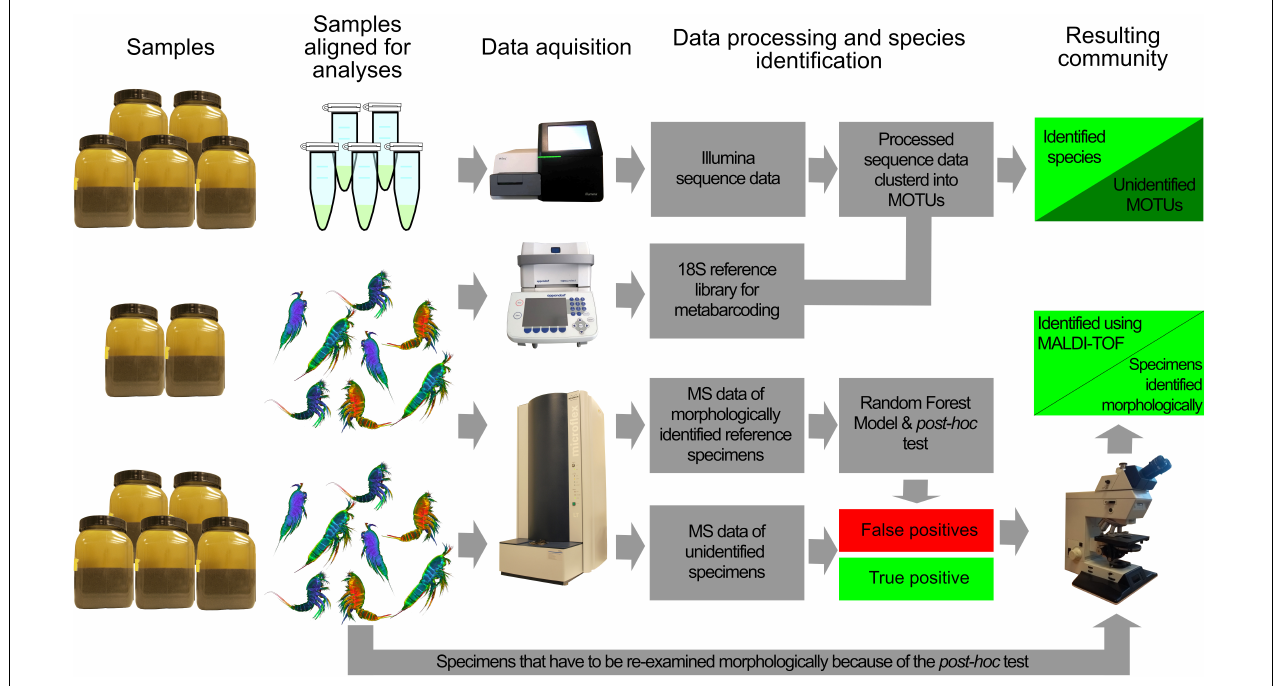
FIGURE 1 | Workflow of community identifications using metabarcoding and MALDI-TOF MS. DNA and MS reference libraries were constructed from specimens of two samples. The DNA library was used to assign species to Illumina MiSeq sequence reads from pooled samples. With incomplete library, this will however result in an unresolved community containing unidentified MOTUs. Based on the MS reference library a Random Forest model is constructed to classify all specimens from samples. The post hoc test is then used to validate or reject classifications. Rejected classifications are re-examined morphologically and subsequently assigned to the correct species. The resulting community consists of species based on MS and specimens identified